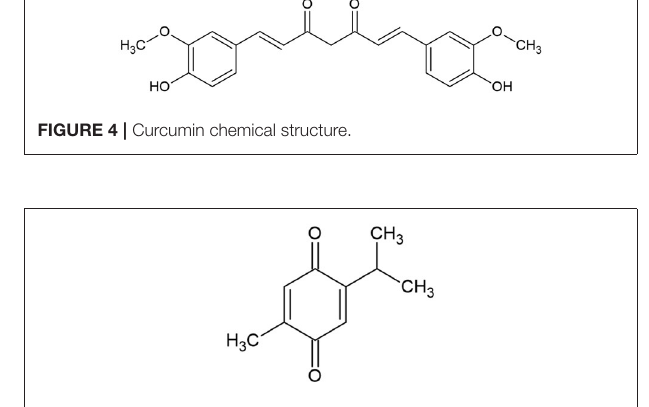
FIGURE 5 | Thymoquinone chemical